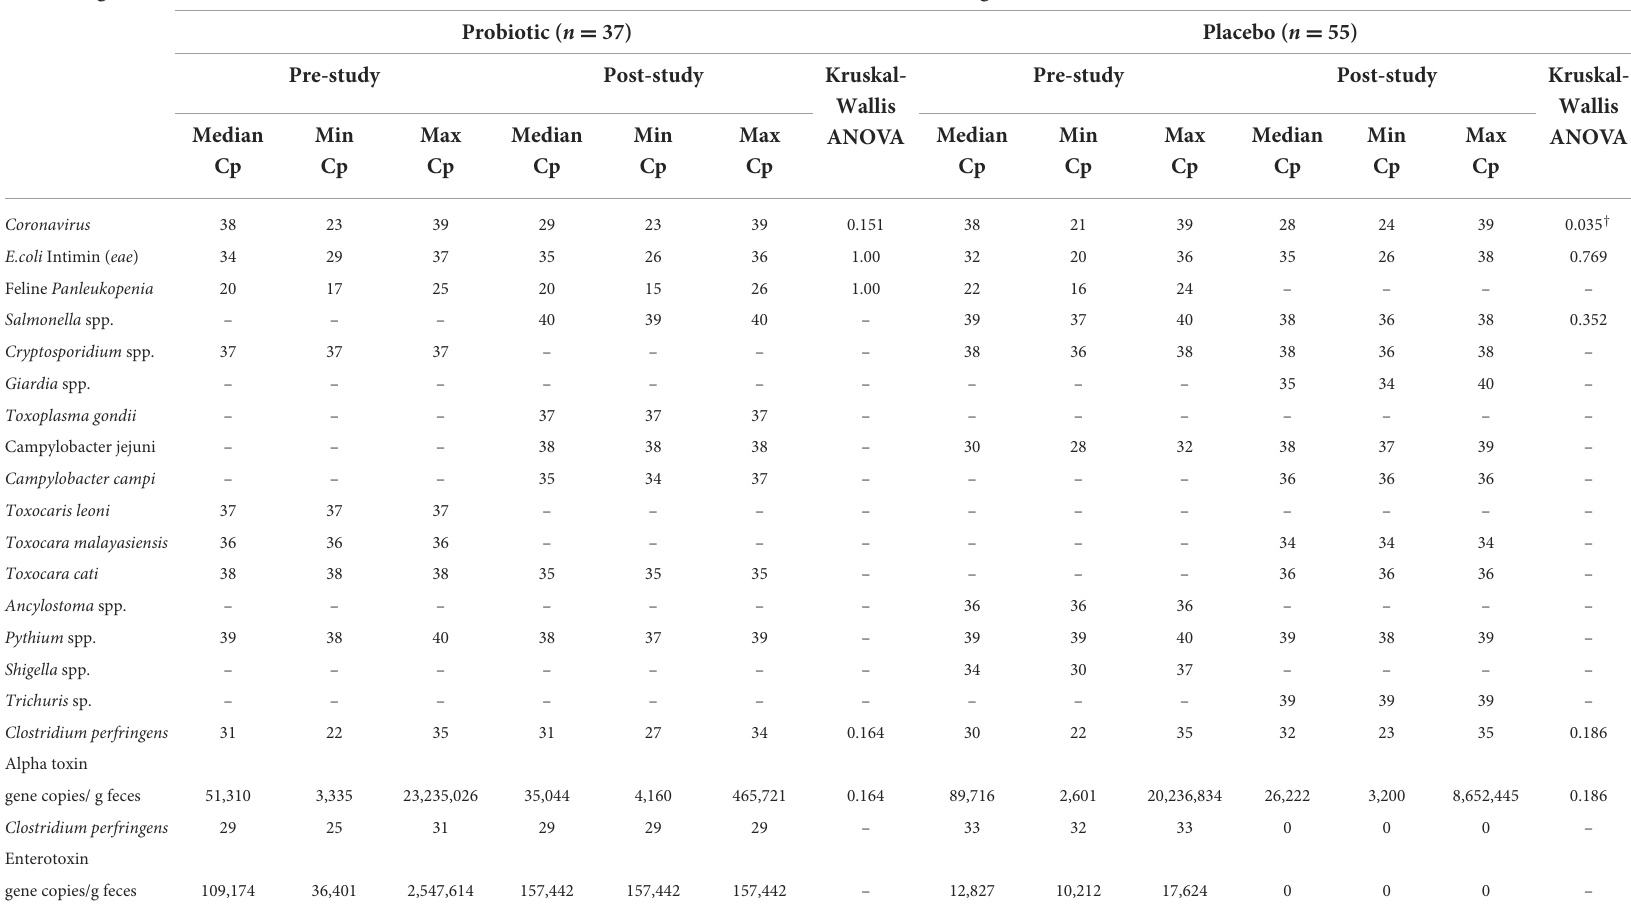
TABLE 3 Abundance of infectious agents identified by RT-PCR or PCR in RNA/DNA extracted from voided feces collected from fostered kittens prior to (pre-study) and upon completion (post-study) of ongoing daily treatment with a probiotic or placebo. Selected agents Burden of infectious agent(s) Probiotic ( n = 37) Placebo ( n = 55) Pre-study Post-study Kruskal- Pre-study Post-study Kruskal- Wallis ANOVA